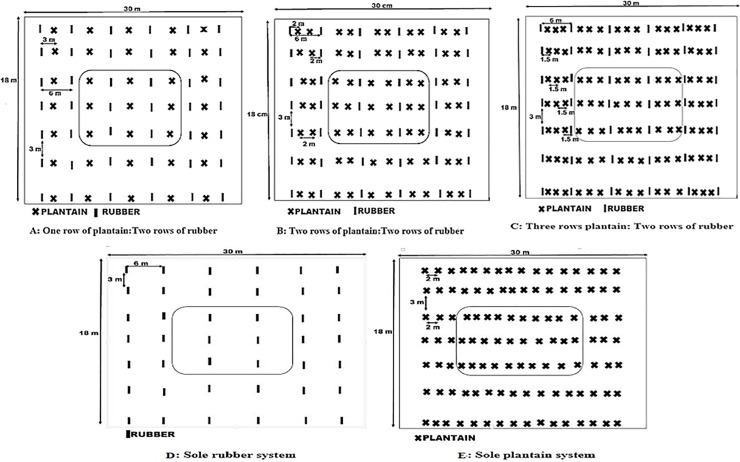
Plant stands of the rubber, plantain and the intercropping systems.The marked plants were the selected plants for the trial.